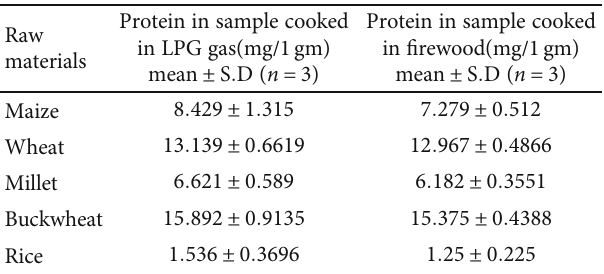
Table 4: Protein content in sample cooked in LPG gas and fi